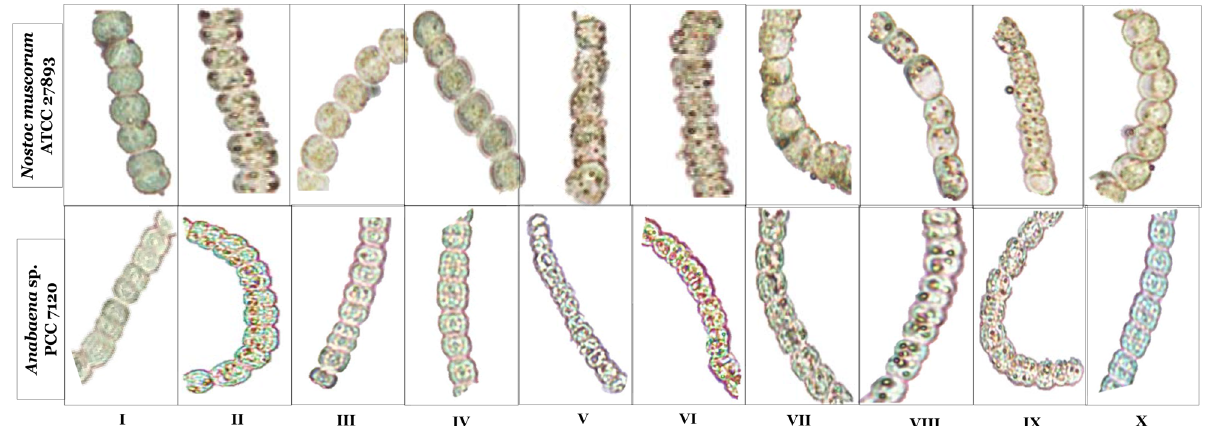
Figure 2. Histochemical analysis of Cd accumulation; red patches inside the cells of Cd stressed Nostoc muscorum ATCC 27893 and Anabaena sp. PCC 7120 exposed to H 2 O 2 and NO (SNP). Where lane I: Control, lane II: Cd, lane III: Cd + H 2 O 2 , lane IV: Cd + SNP, lane V: Cd + H 2 O 2 + PTIO, lane VI: Cd + H 2 O 2 + L NAME, lane VII: Cd + SNP + NAC, lane VIII: Cd + SNP + DPI, lane IX: Cd + H 2 O 2 + SNP + PTIO + L NAME, lane X: Cd + H 2 O 2 + SNP + NAC +